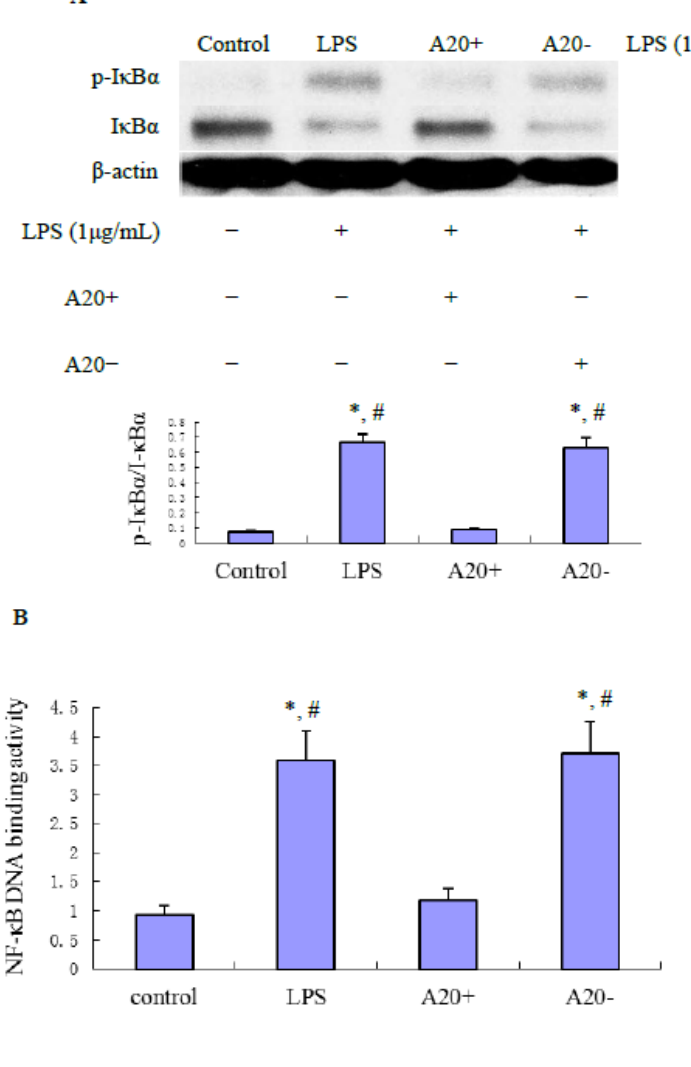
Figure 3. Effect of A20 on LPS-induced NF- κ B signaling in RPMCs. ( A ) Cells were pre-transfected with pGEM-T easy- A20 or pGEM-T easy for 24 h. Near confluent cells were incubated with serum-free medium for 24 h to arrest and synchronize cell growth and then exposed to LPS (1 μ g/mL) for 1 h. Protein lysates were prepared and subjected to immunoblotting with antibodies against phospho-I κ B α or I κ B α . Western blots are representative of three independent experiments. Bar graph shows the expression of phospho-I κ B α /I κ B α . Data are presented as the mean ± SD ( n = 3). * p < 0.01 vs. control; # p < 0.01 vs. A20+; ( B ) Inhibitory effect of A20 on LPS-induced NF- κ B activation in RPMCs. RPMCs were pre-transfected with pGEM-T easy- A20 or pGEM-T easy for 24 h. Near confluent cells were cultured in serum-free medium for 24 h to arrest and synchronize cell growth and then exposed to LPS (1 μ g/mL) for 1 h. The DNA-binding activity of NF- κ B p65 in nuclear extracts of RPMCs was measured using a NF- κ B p65 transcription factor assay kit. Results were obtained from three independent experiments. Data are presented as the mean ± SD ( n = 3). * p < 0.01 vs . control; # p < 0.01 vs .